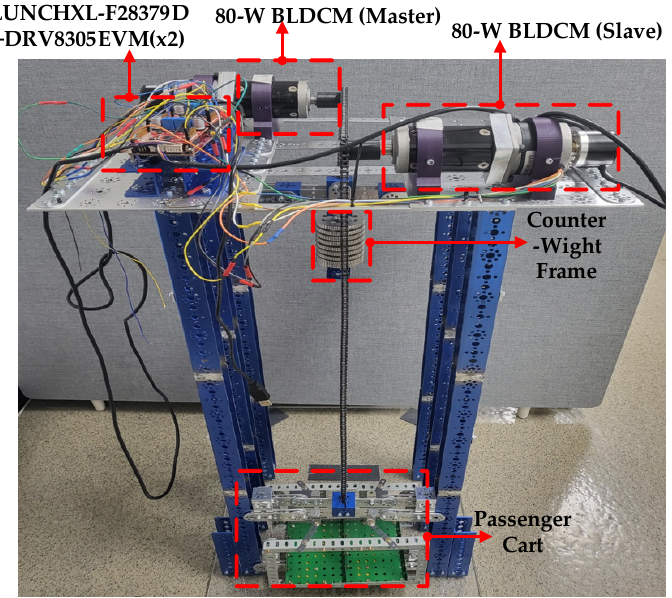
Figure 4. Experimental